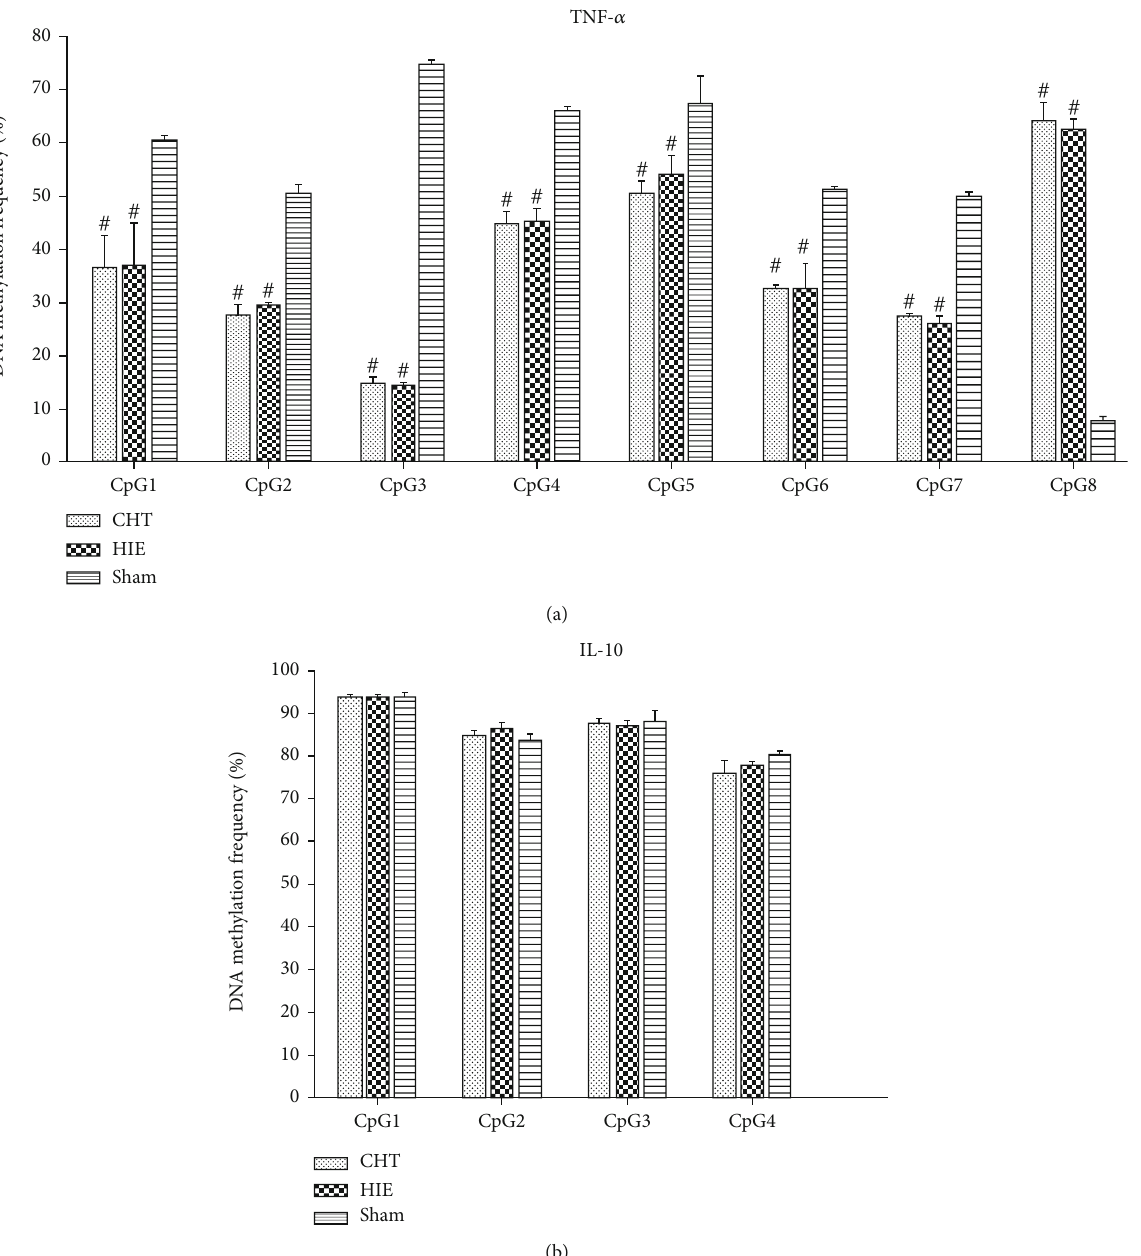
Figure 5: DNA methylation level in the promoter region of cytokines TNF- α and IL-10. # P < 0 : 05 : comparison with the sham group, n = 3